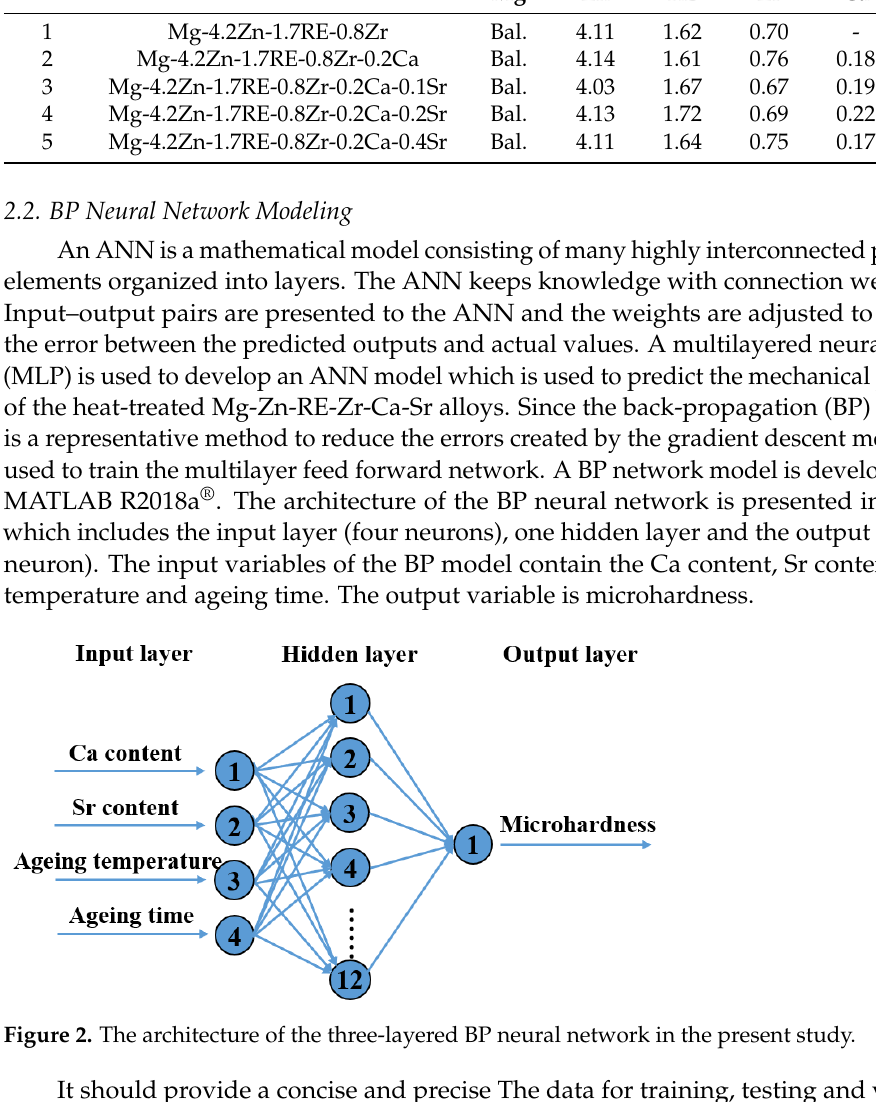
Table 1. Chemical compositions of the as-cast alloys (wt.%).